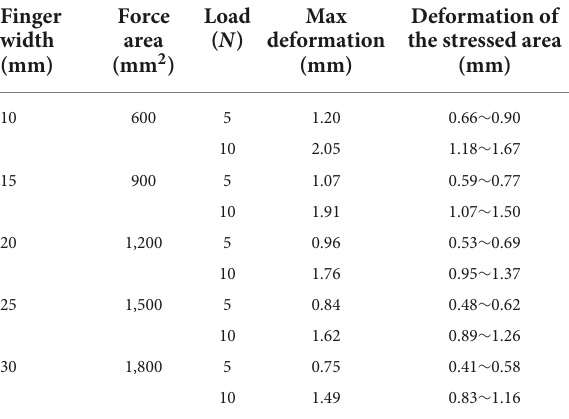
TABLE 4 Statistics for tomato grip types.